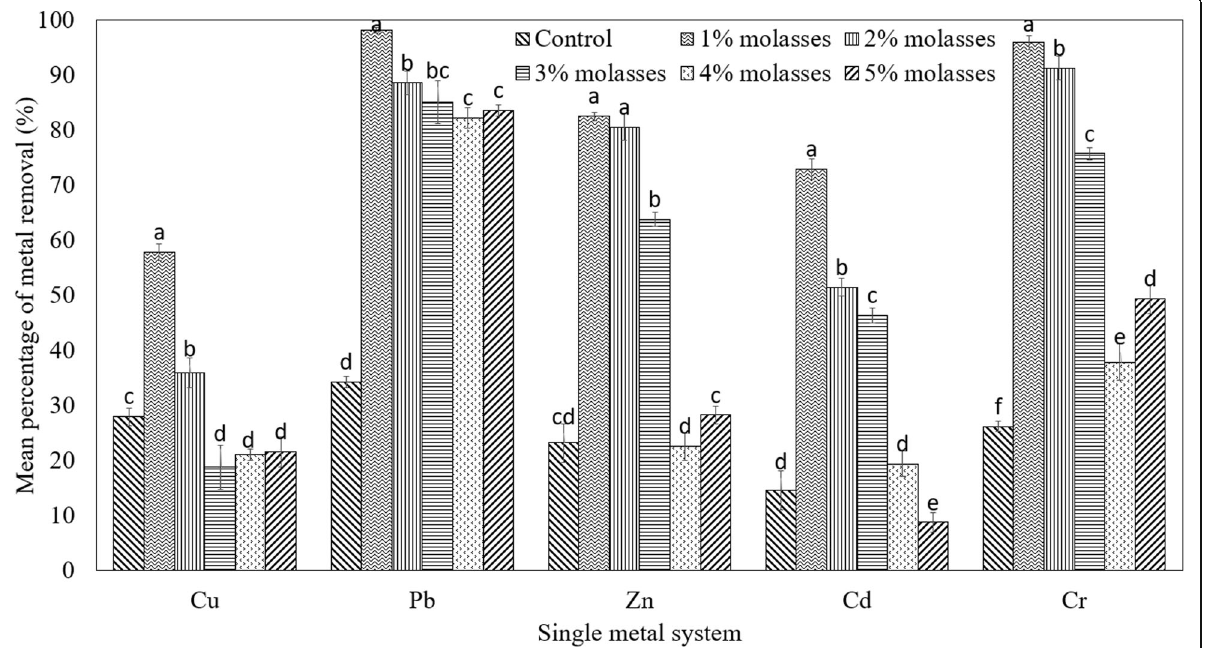
Fig. 7 Mean percentage (%) of metal (Cu, Pb, Zn, Cd, Cr) removal by EPS derived from single culture of B. cereus subjected to various concentrations of sugarcane molasses (1, 2, 3, 4, 5%) during cultivation. Metal removal test was performed in single metal systems. Means with the same letters within the metal type indicate no significant difference according to Tukey comparisons ( p < 0.05). Bars indicate standard deviation of